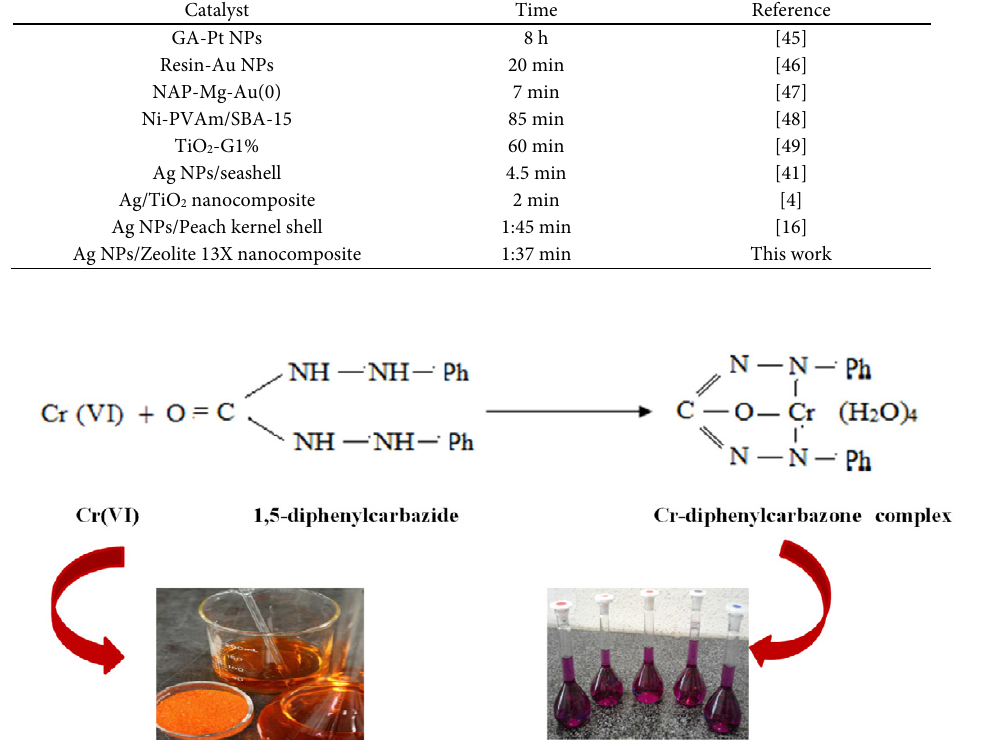
Fig. 11. Structure of 1, 5- diphenylcarbazide and Cr - diphenylcarbaone complex